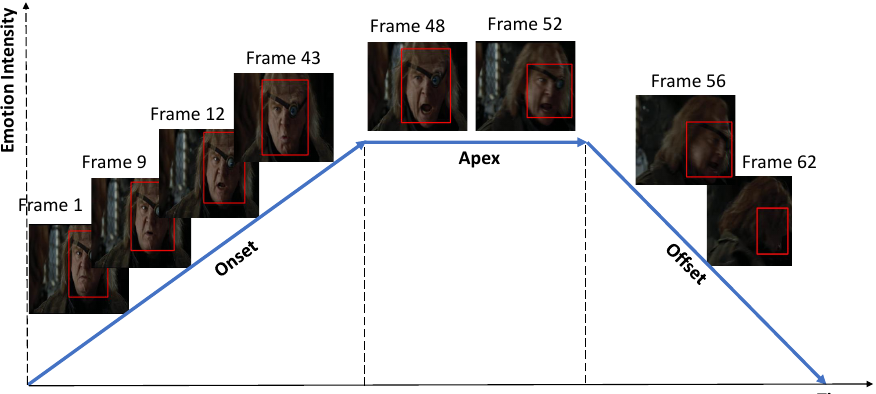
Figure 1. The three periods of facial expression representation are onset, apex, and offset. The dura- tion of each varies, leading to unclear temporal borders. In addition, the appearance of spontaneous expressions leads to the presence of multiple apexes